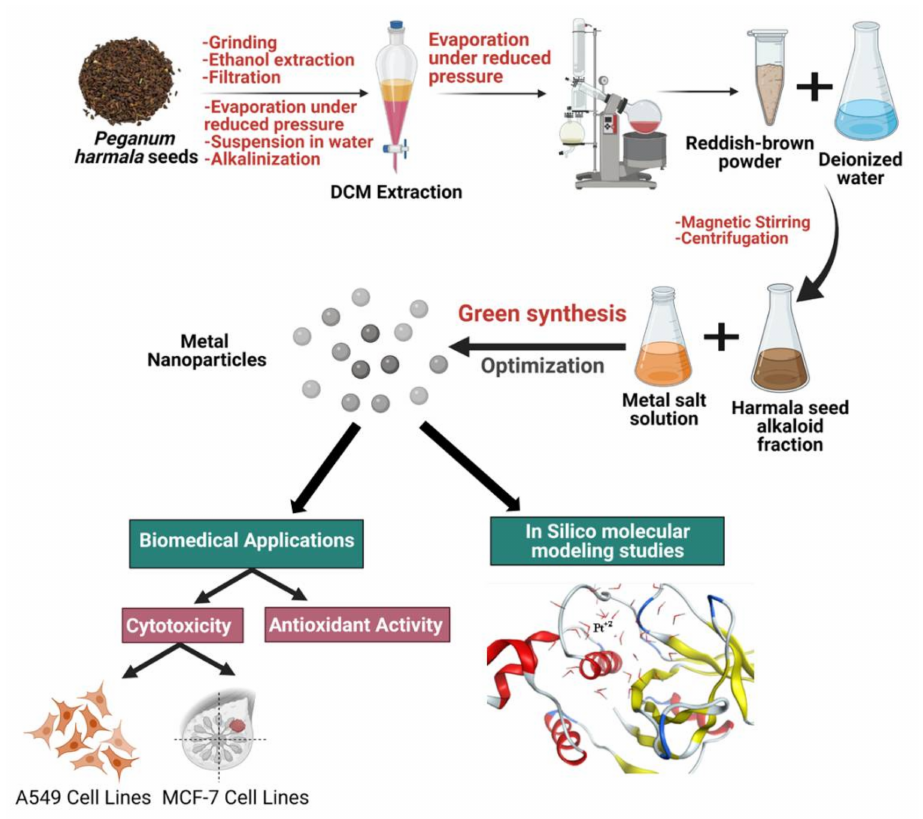
Scheme 1. Schematic diagram summarizing the steps involved in the green synthesis of platinum and palladium nanoparticles (Pt NPs, Pd NPs), and Pt–Pd